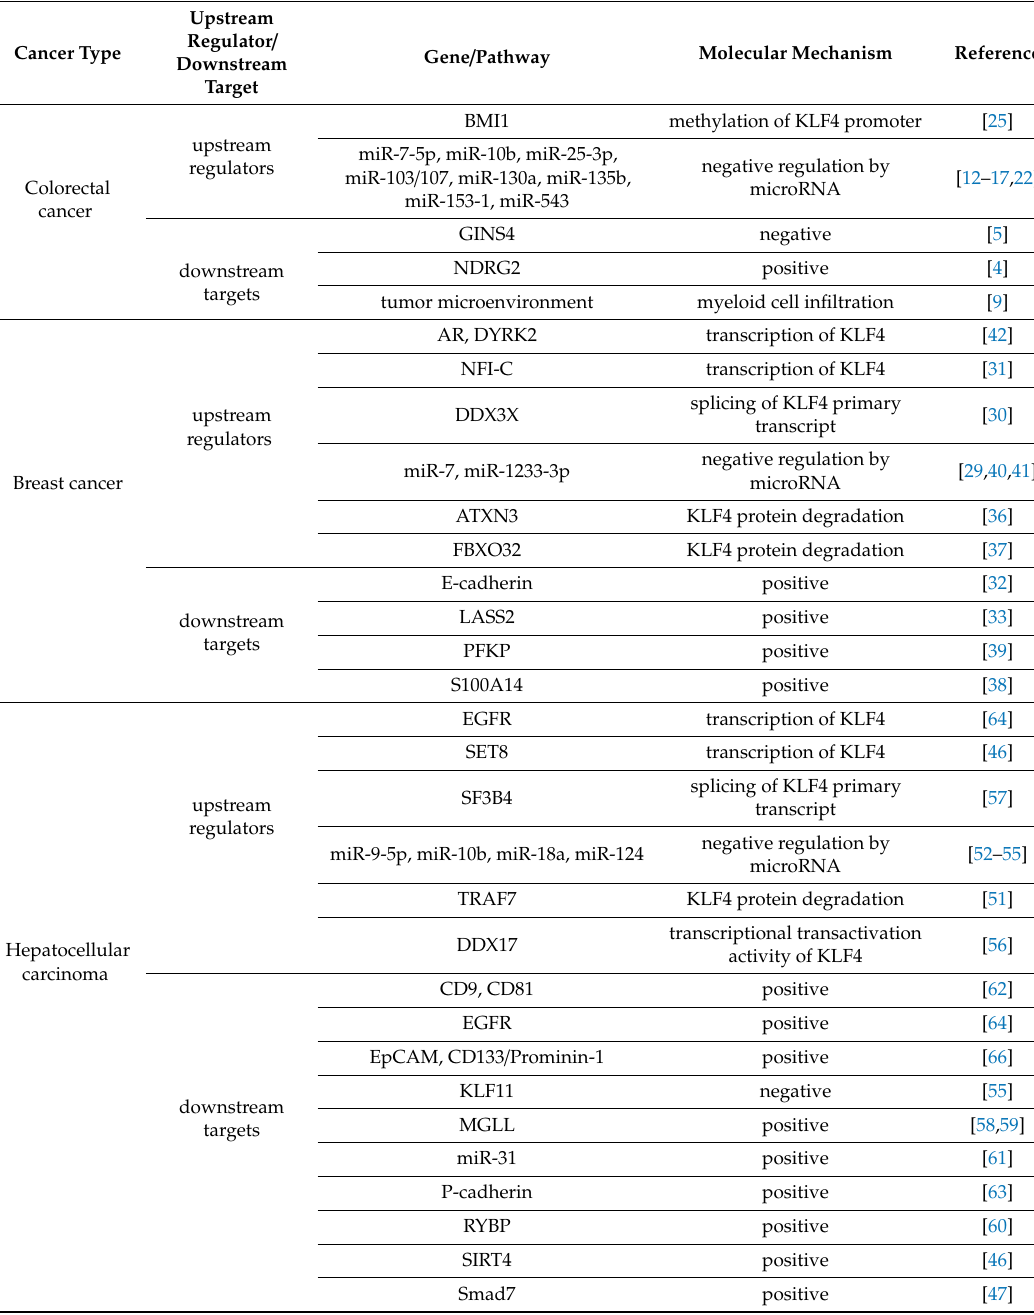
Table 1. Summary of the molecular mechanisms responsible for the involvement of KLF4 in the most common cancer types. Since KLF4 is a transcription factor, almost all of its downstream targets are regulated at the level of transcriptional initiation. Thus we only include statements “positive” and “negative” to indicate whether the transcription of this particular target gene is regulated positively or negatively by